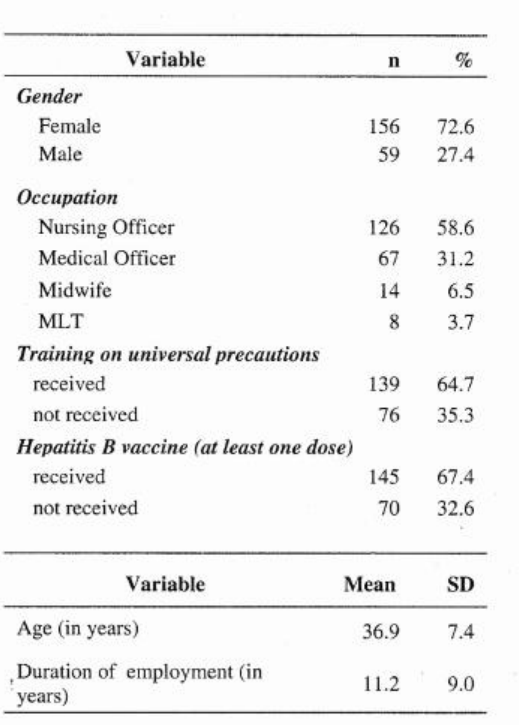
Table 1. Demographic and work-related